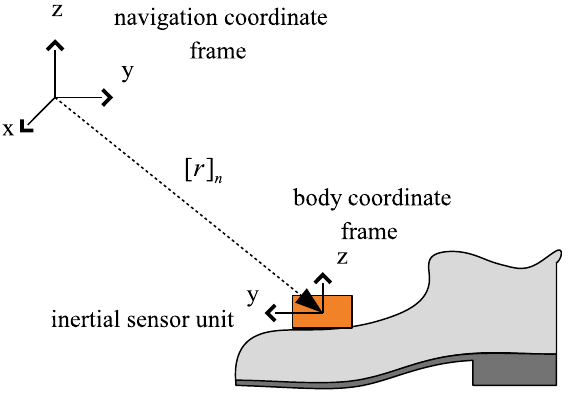
Figure 1. Overview of the foot inertial sensor